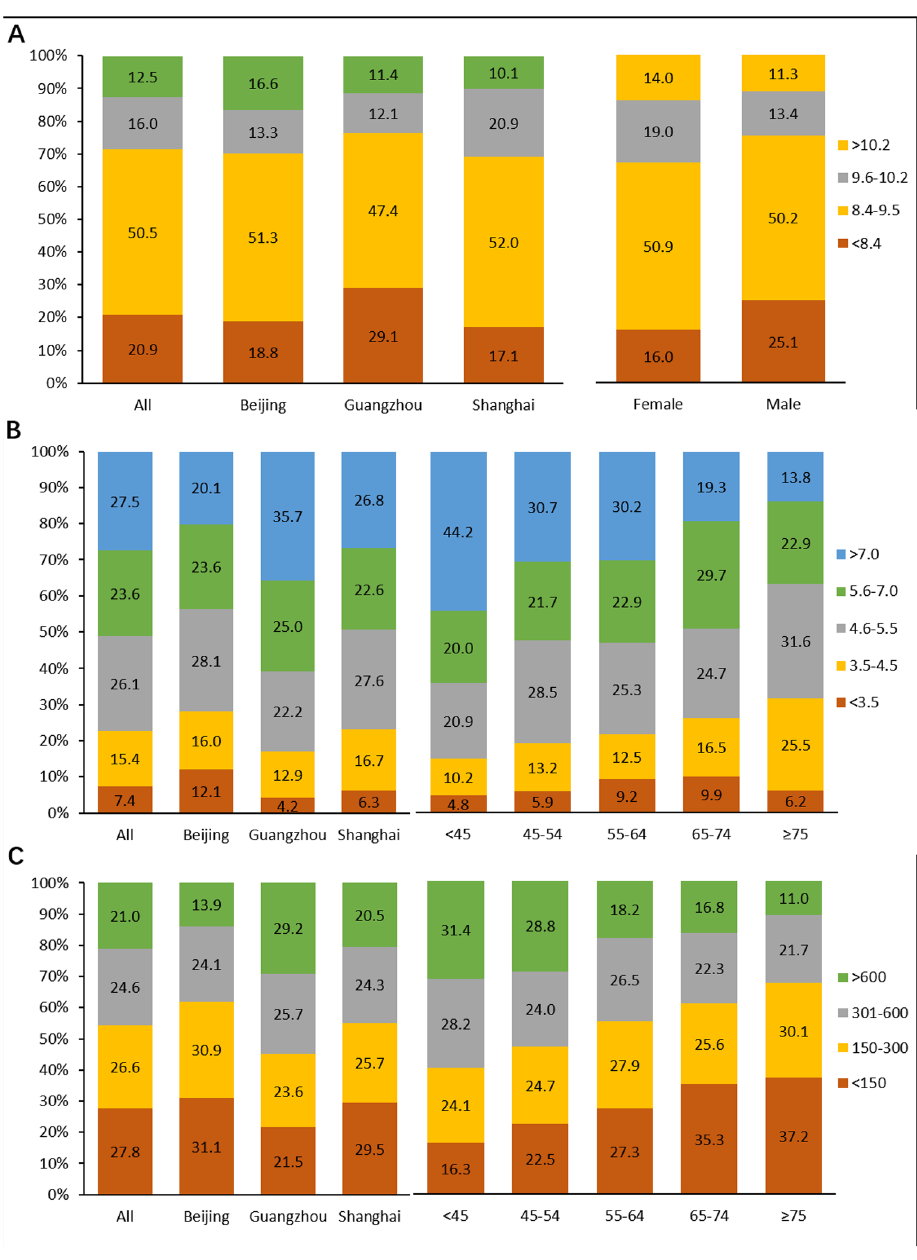
Figure 3. The distribution of bone mineral markers. ( A ) The distribution of serum cCa stratified by city and gender groups; ( B ) the distribution of serum P stratified by city and age groups; ( C ) the distribution of iPTH stratified by city and age